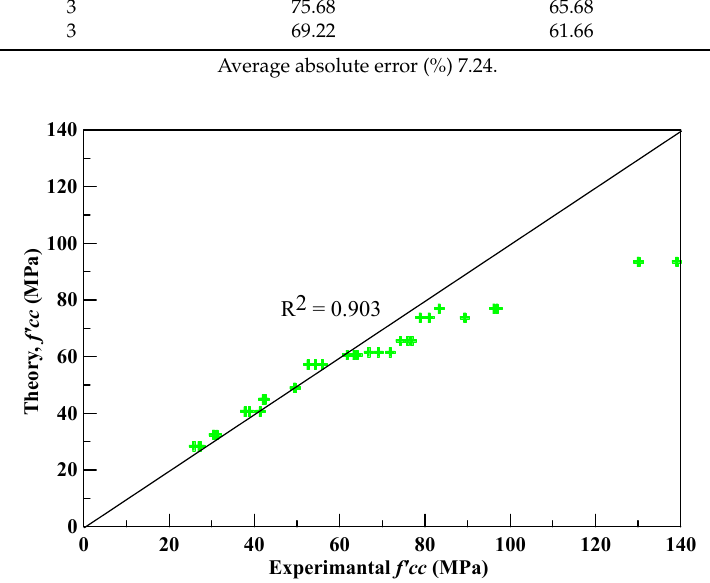
Figure 7. The deviation and correlation coefficient of the analytical and experimental maximum compressive strengths.